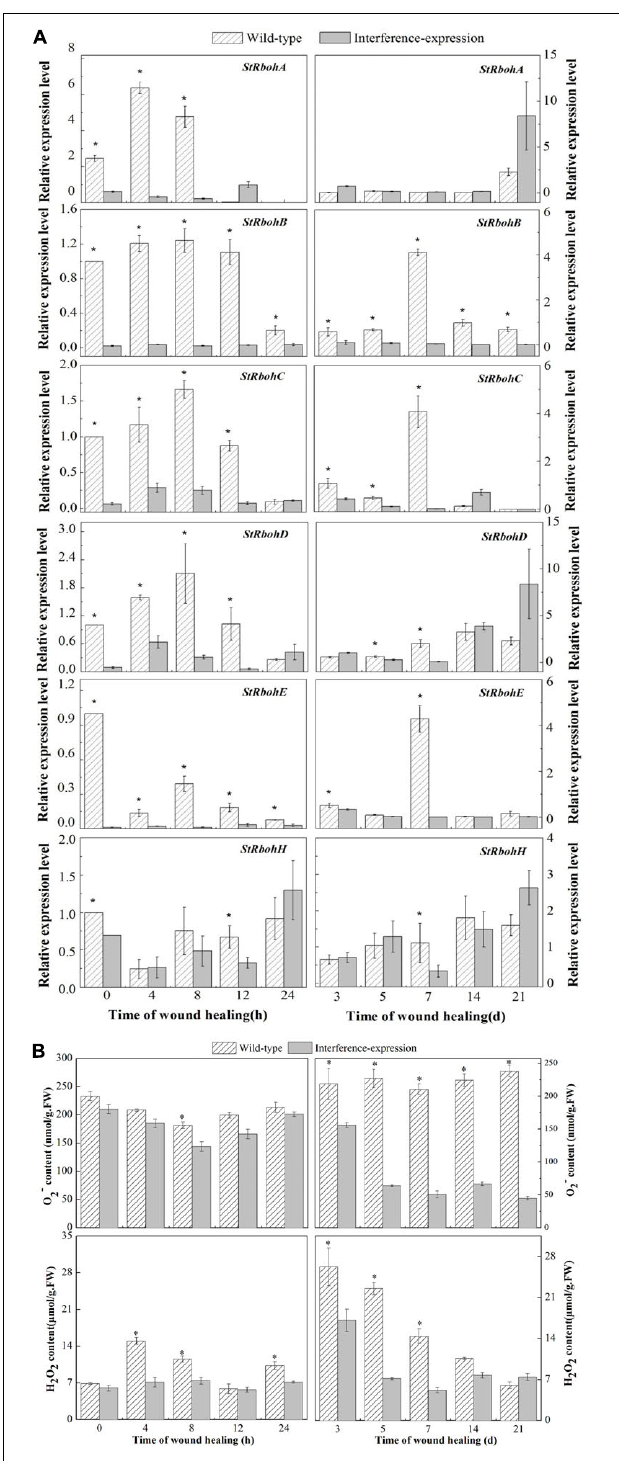
FIGURE 7 | Relative expression of StRbohs genes and O 2 − and H 2 O 2 content during healing in potato tubers. (A) The relative expression of StRbohs genes in transgenic tubers. (B) The O 2 − and H 2 O 2 content during healing in transgenic tubers. The potato elongation factor 1-alpha 1 ( efla) gene was used as an internal control to normalize the data. The mean ( ± SD) represents the value of three replicates. Asterisks indicate statistical significance ( P <